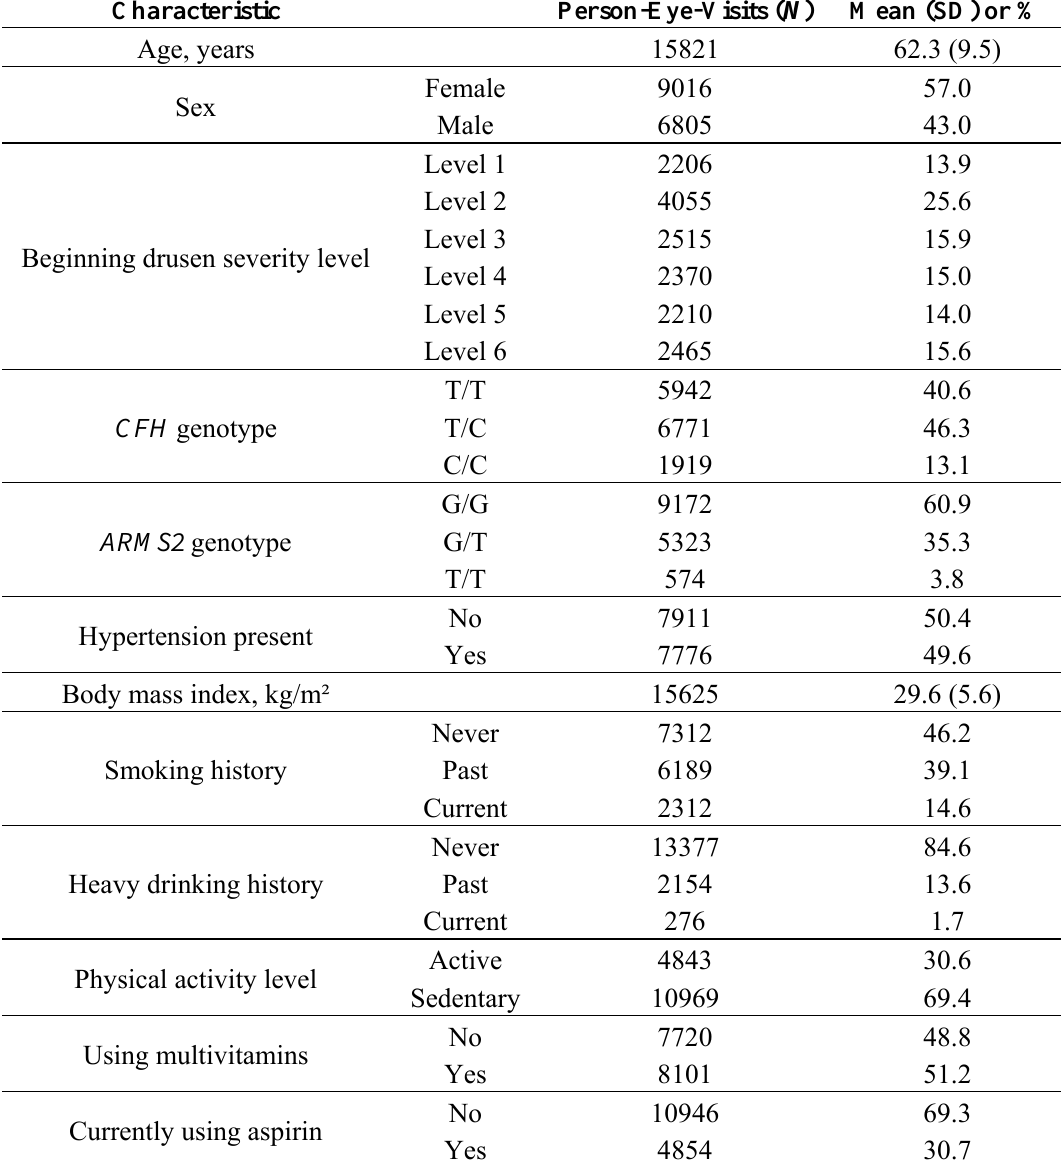
Table 1. Characteristics of individuals included in analyses averaged over all examination phases in the Beaver Dam Eye Study, 1988–1990 to 2008–2010. ARMS2 , age-related maculopathy susceptibility 2 rs10490924; CFH , complement factor H rs1061170; SD, standard